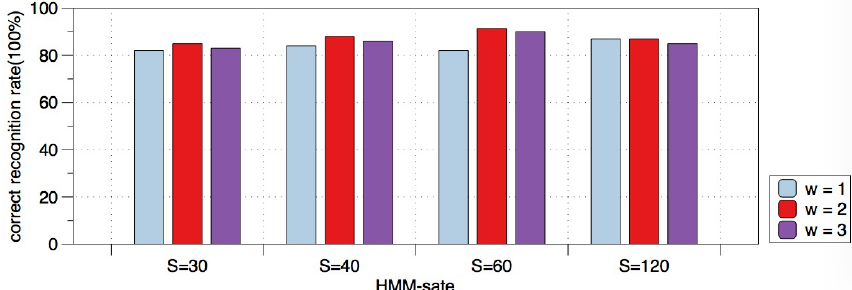
Figure 13. Different configuration of HMM model in MIBL-HMM algorithm obtains different recognition